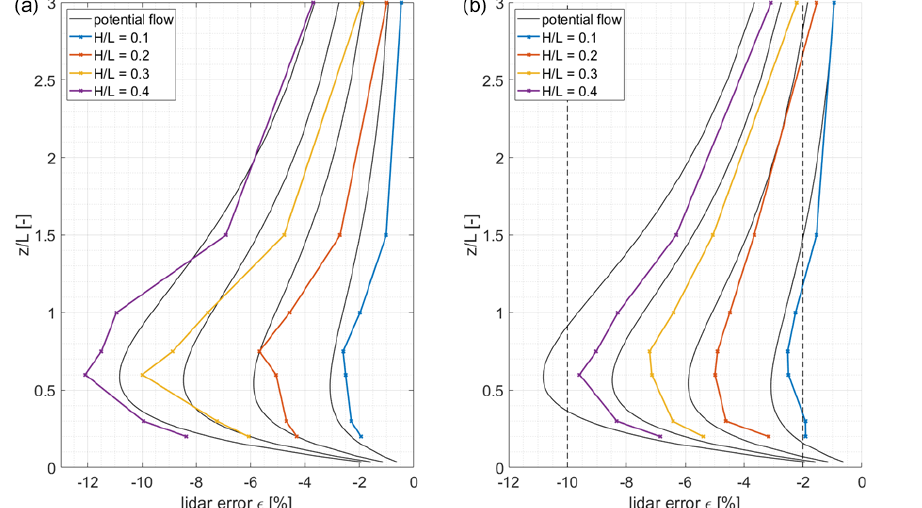
Figure 6. Lidar error ε in dependence of the ratio H/L between z/L ratios from 0 to 3 for a roughness length of 0.005m. (a) Based on results from WAsP Engineering. (b) Based on results from Meteodyn WT. The black lines show results from the potential flow model.